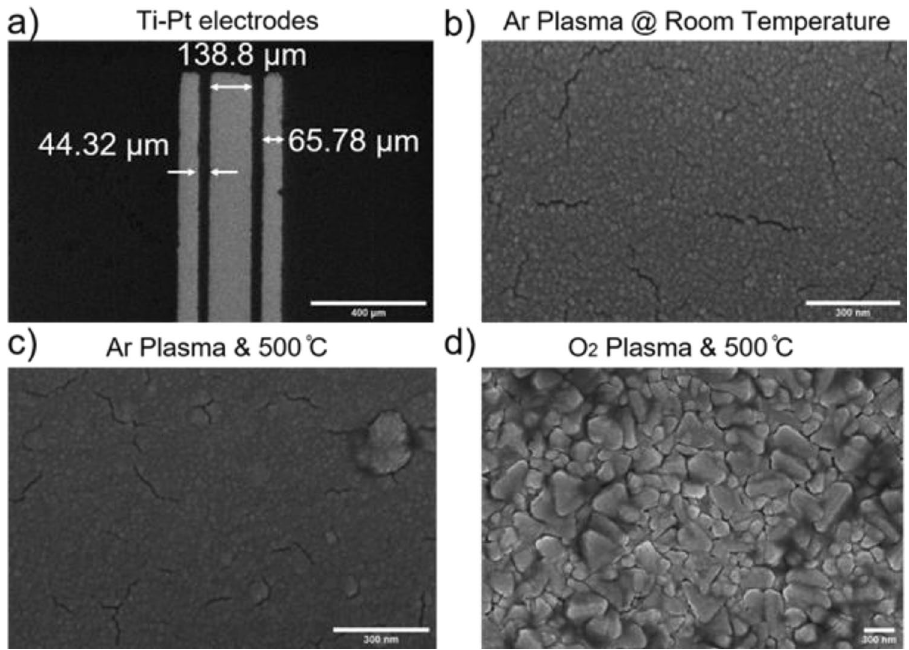
Figure 7. SEM images of microelectrodes fabricated on a polypropylene film. ( a ) Three coplanar electrodes with dimensions according to photomask Design M, ( b ) Titanium and platinum thin film deposition in argon plasma at room temperature, 40 nm & 100 nm, respectively, ( c ) Ti/Pt thin film deposited in argon plasma in magnetron sputter at elevated temperature, 500 °C, ( d ) Ti/Pt thin film deposited in oxygen plasma in magnetron sputter at elevated temperature, 500